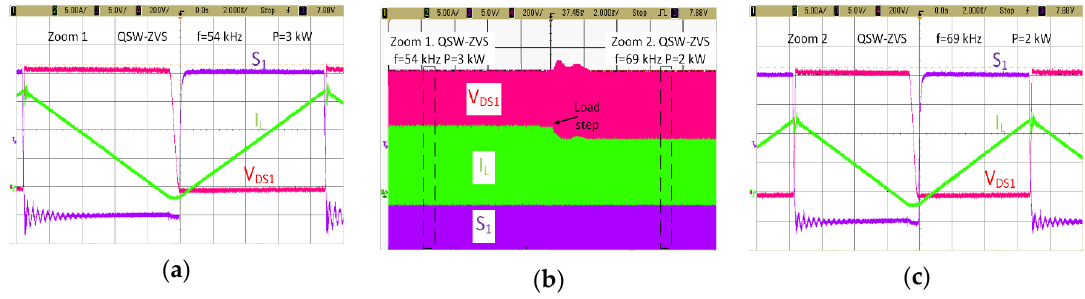
Figure 16. Experimental results showing the automatic change of the switching frequency in QSW-ZVS under a load step (3 kW to 2 kW). ( a ) Zoom at 3 kW and 54 kHz, ( b ) general view and ( c ) zoom at 2 kW and 69 kHz. V DS1 (pink), I L (green) and S 1 (violet).